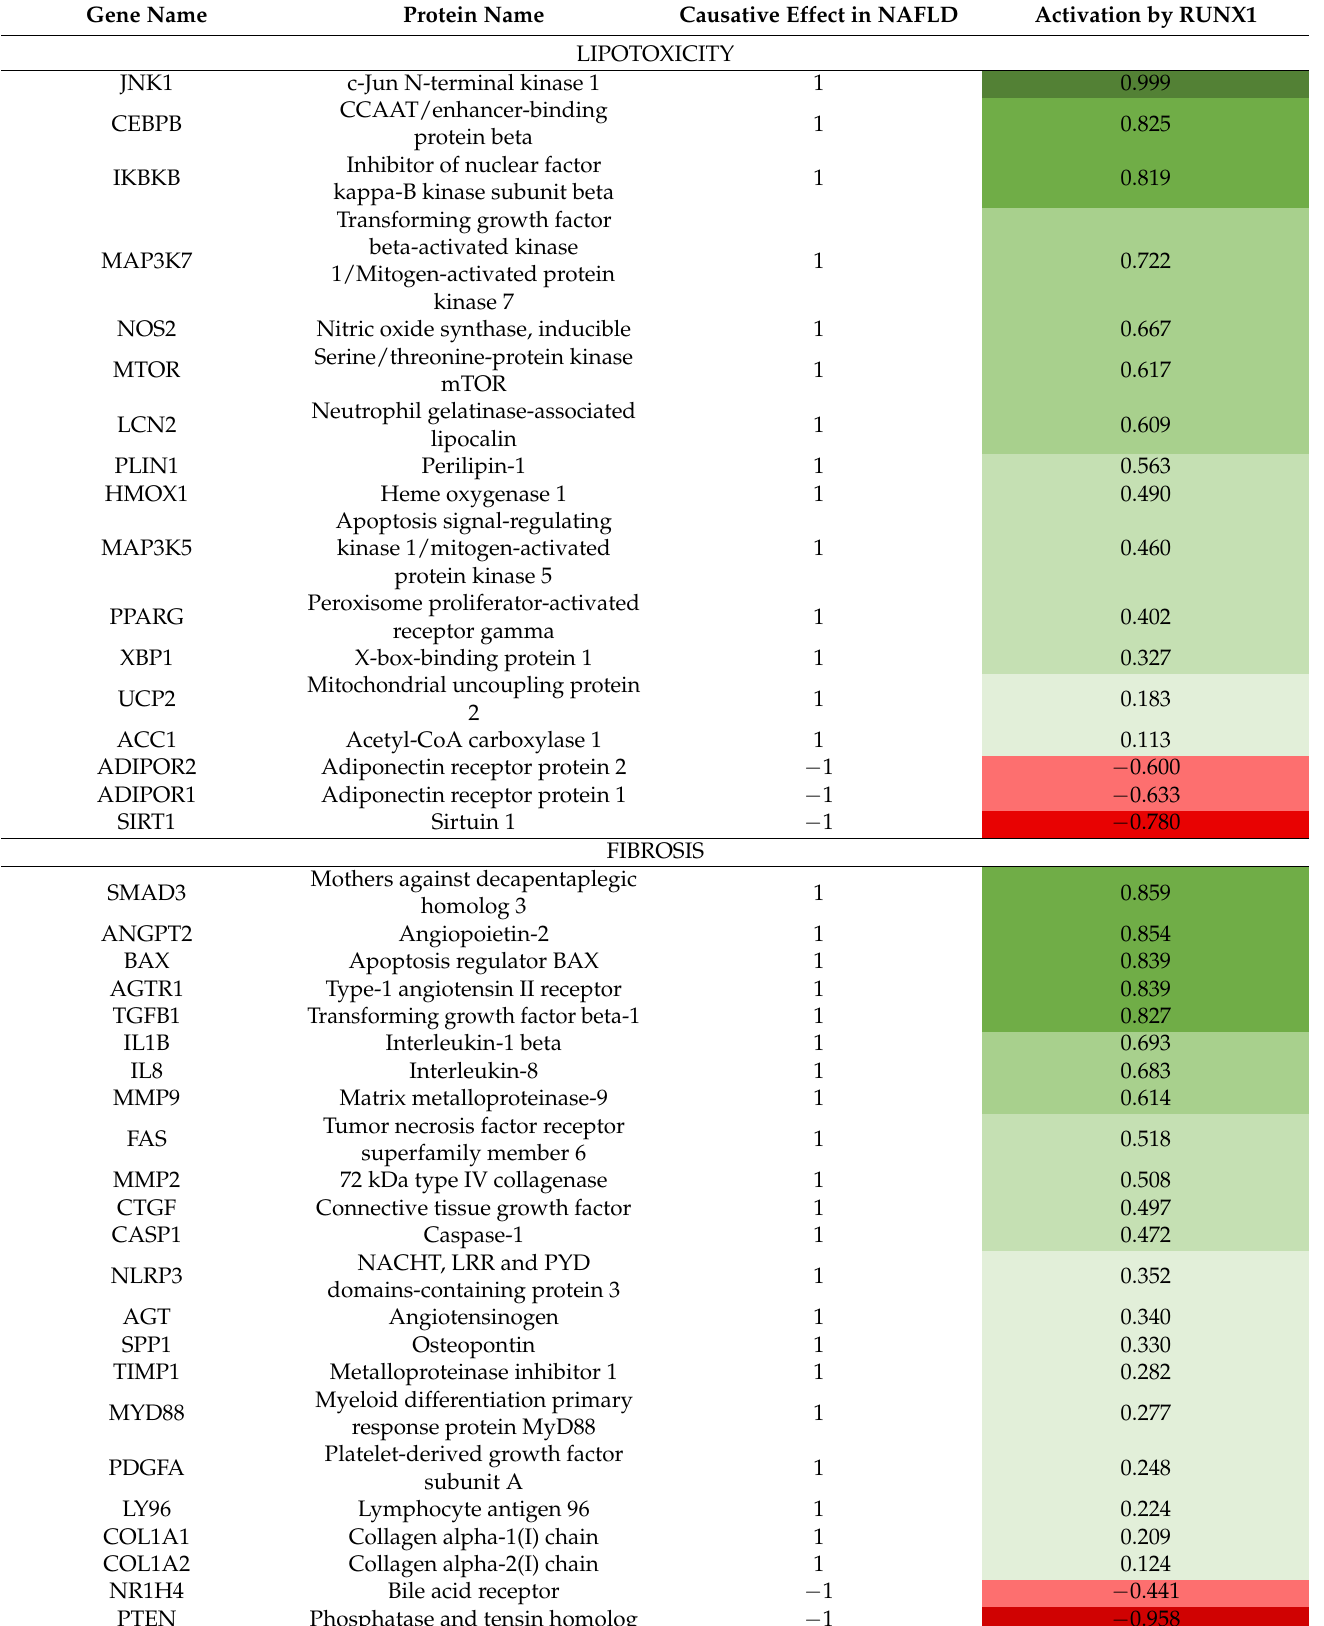
Table 3. Lipotoxicity and fibrosis effector proteins modulated when RUNX1 is